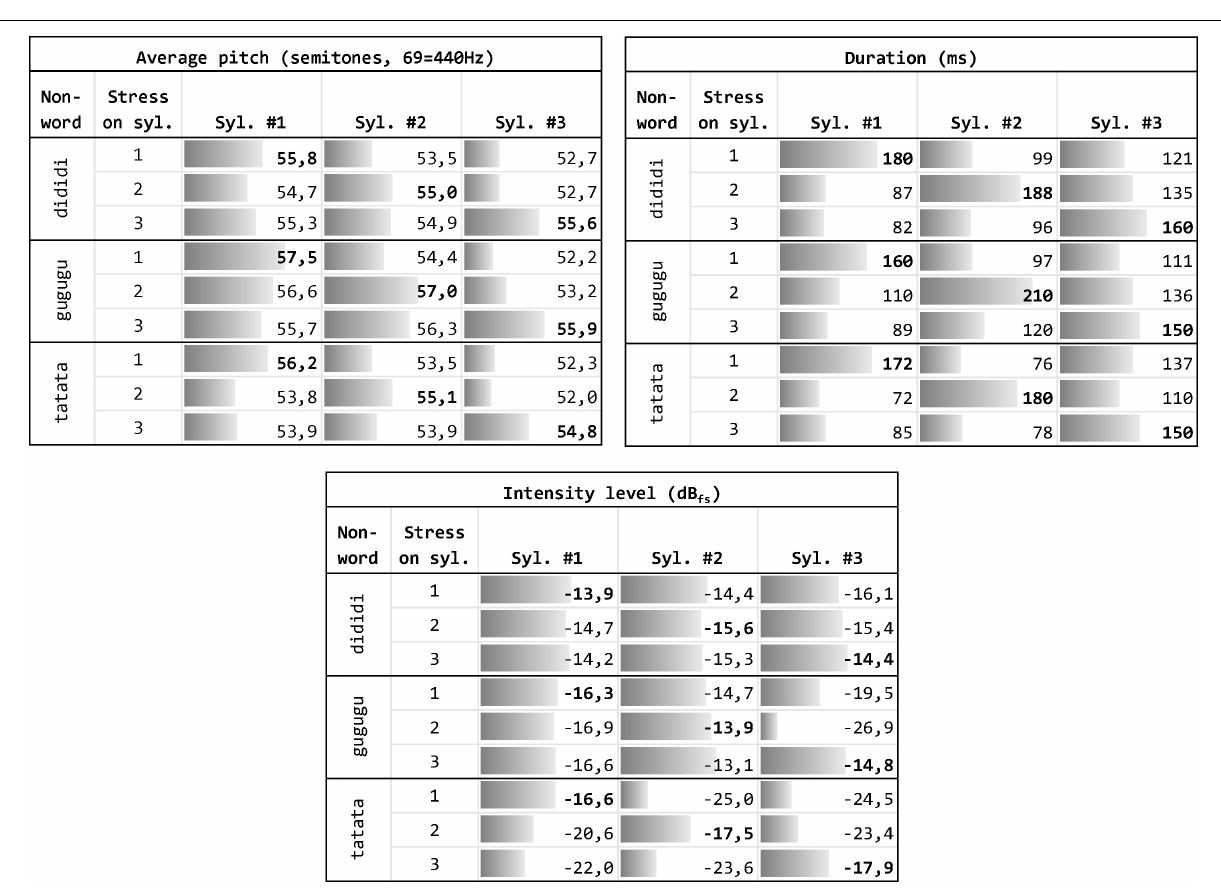
FIGURE 1 | Measurement of the basic features of the nine original recordings. Values concerning the stressed syllable are reported in